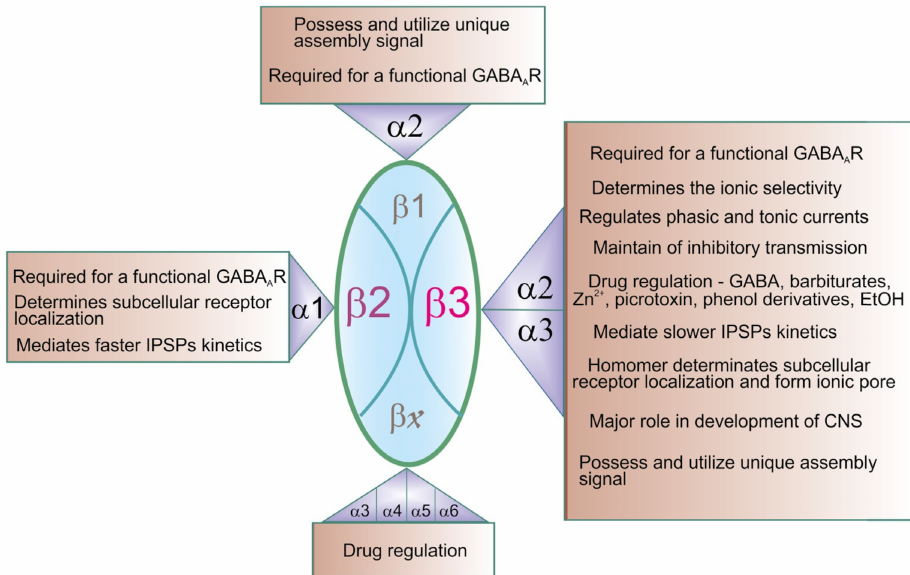
Figure 2. Contribution of the β subunits in heterogeneity and functional properties of γ -aminobutyric acid type A receptors (GABA A Rs). In the central nervous system (CNS), the majority of expressed GABA A Rs are β 2-containing ( α 1 β 2 γ 2) and β 3-containing ( α 2 β 3 γ 2 and α 3 β 3 γ 2) ensembles [27,28]. The β 1-containing subtypes are in fewer in number. The β 2-containing subtypes demonstrated a low range of properties. The β 3-containing ensembles appear to have diverse properties (including maintaining properties of the inhibitory transmission and the determination of the ionic